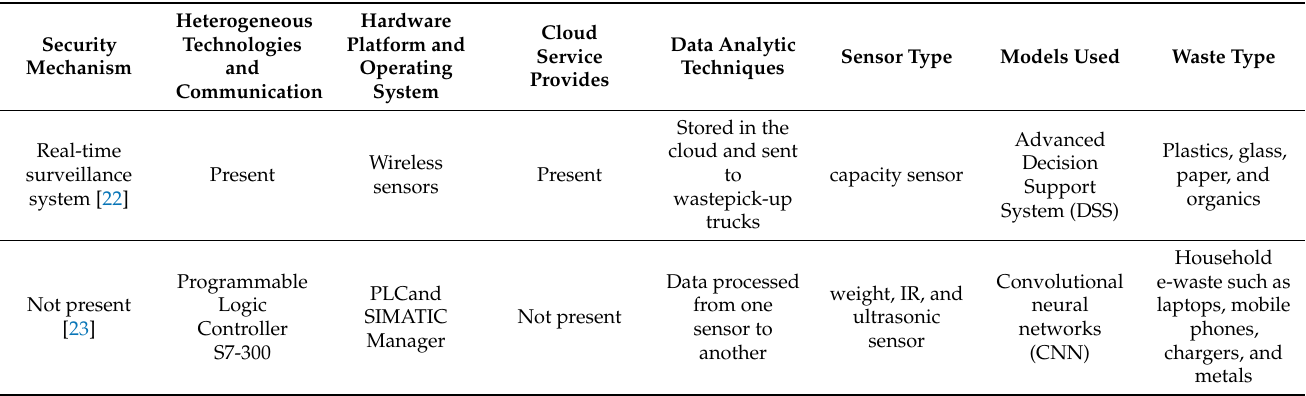
Table 1. Literature of smart garbage disposal